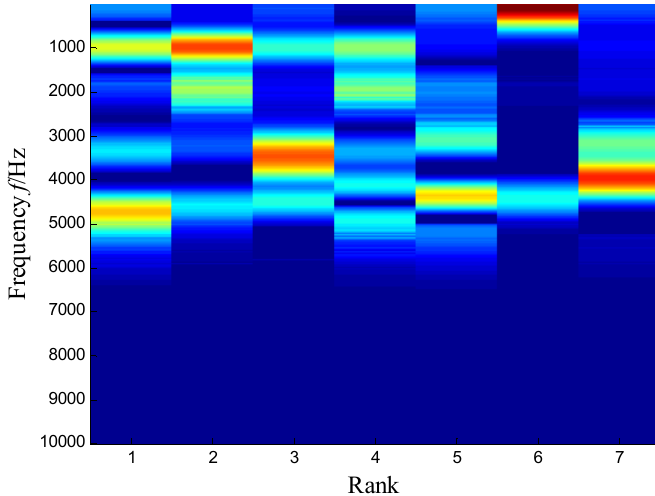
Figure 15. Coefficient matrix obtained by NMF.